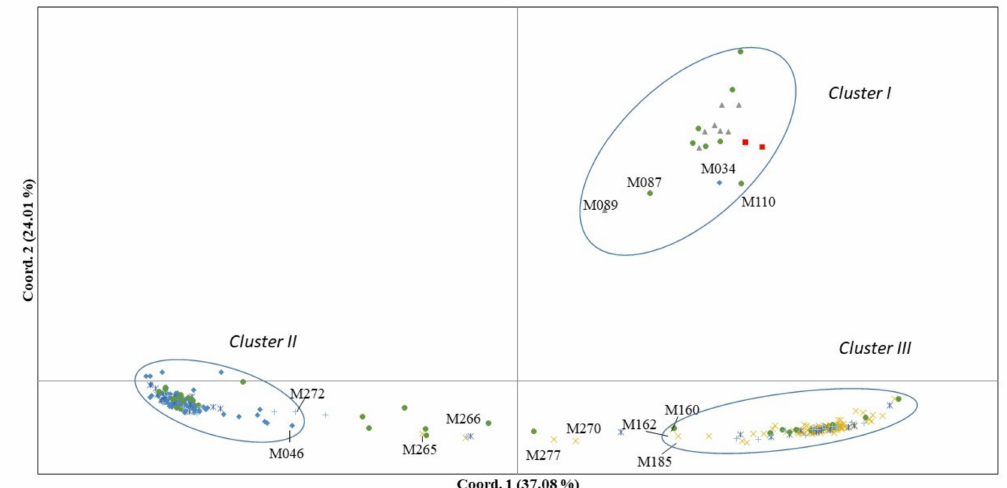
Figure 3. Principal coordinate analysis (PCoA) of the 302 accessions based on 2872 SNP markers, showing the three distinct groups and the admixtures. The first two coordinates of PCoA explained 34.06% of the total